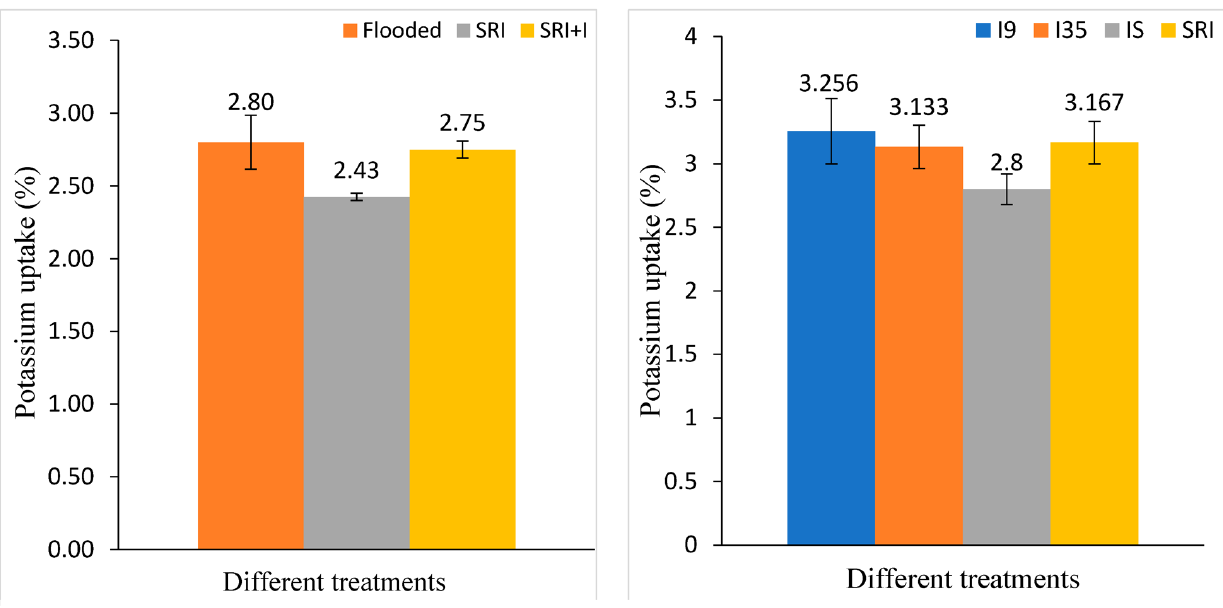
Figure 10. Potassium uptake as measured in the different treatments. Conventional flooded rice (CFR), SRI, and SRI with intercropping (SRI+I or SRIBI) in 2017 ( Left ). SRI and three different intercropping configurations in 2018 ( Right ).